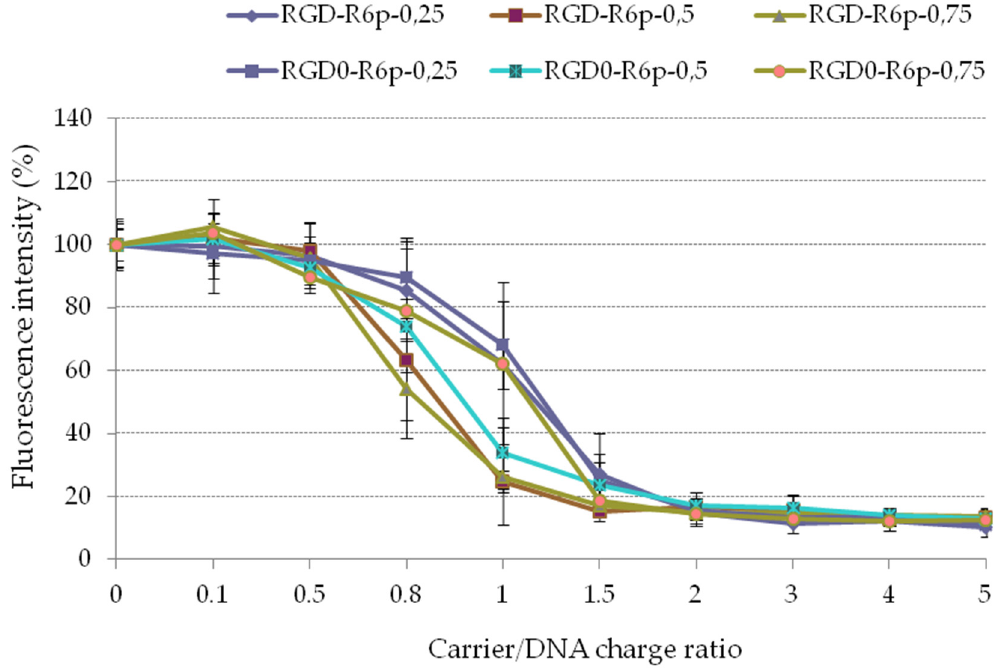
Figure 1. EtBr exclusion assay of DNA complexes with the peptide carriers. Values are the mean ± SD of the mean of triplicates.